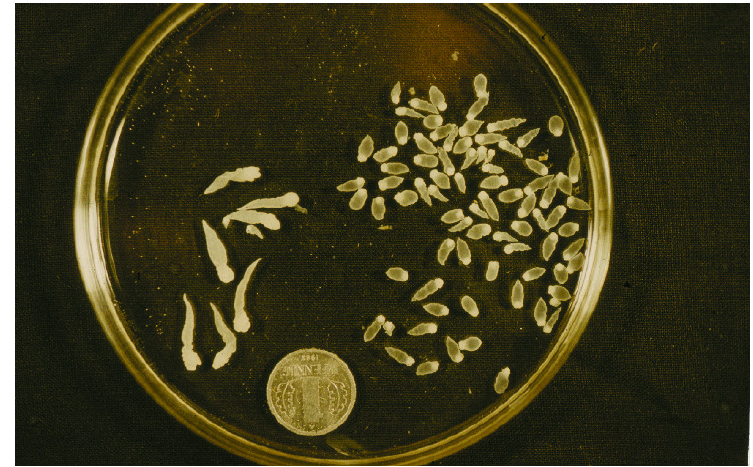
Figure 12. Larval stages of Taenia polyacantha removed from thorax of a muskrat.